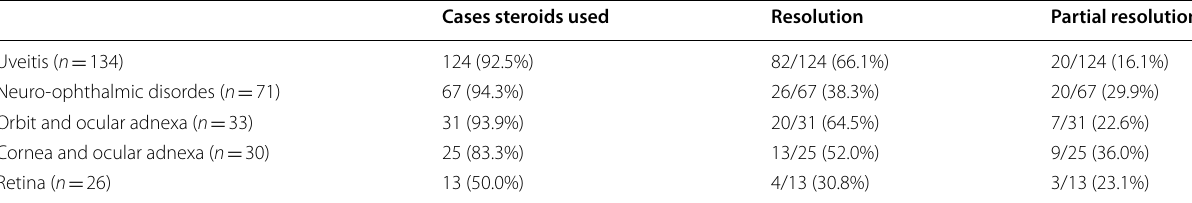
Table 6 Results of steroid